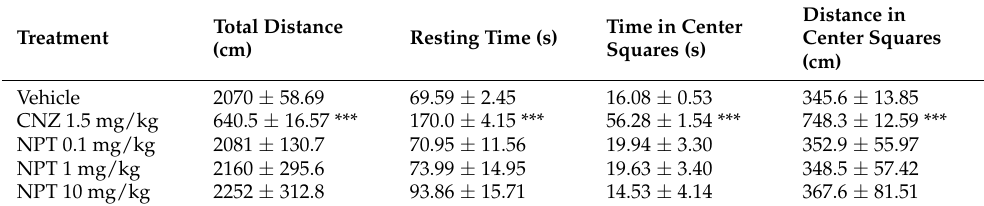
Table 1 . E ff ects of NPT in the OFT . Table 1. Effects of NPT in the